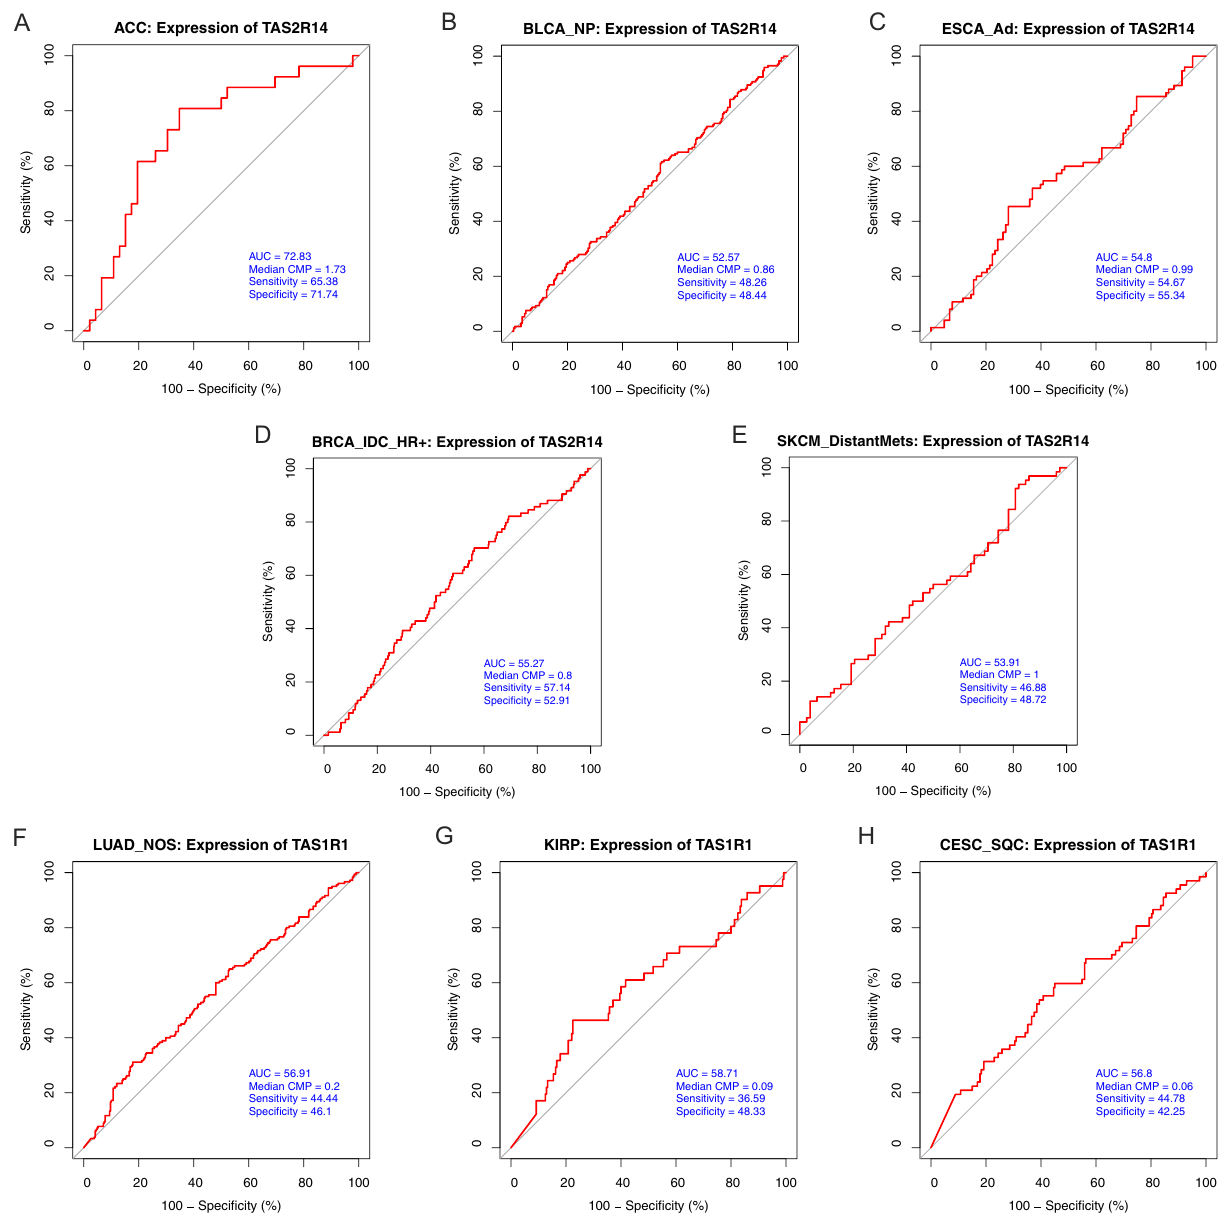
Figure 7. Prognostic roles of TAS2R14 and TAS1R1 for survival in solid tumors. Gene expression data from TCGA was used to generate receiver operating characteristic (ROC) curves using the median counts per million (CPM) cutoffs used in the Kaplan-Meier survival curves from Fig. 6. ROC curves are shown for TAS2R14 in ( A ) adrenocortical cancer (ACC), ( B ) non-papillary bladder cancer (BLCA_NP), ( C ) esophageal adenocarcinoma (ESCA_AD), ( D ) hormone receptor positive infiltrating ductal breast carcinoma (BRCA_IDC_HR +), and ( E ) distantly metastatic skin melanoma (SKCM_DistantMets). ROC curves were also generated for TAS1R1 in ( F ) lung adenocarcinoma (LUAD_NOS), ( G ) kidney papillary cell carcinoma (KIRP), and ( H ) cervical esophageal squamous cell carcinoma (CESC_SQC). The red line represents the sensitivity curve, and the blue line represents random chance. The X axis shows the false positive rate, presented as ‘100–Specificity (%)’. The Y axis indicates the true positive rate, shown as ‘Sensitivity (%)’. The area under the receiver operating characteristics was highest for TAS2R14 in adrenocortical cancer (sensitivity 65.4% and specificity 71.7%). ACC adrenocortical cancer; BLCA_NP non-papillary bladder cancer; BRCA_IDC_HR + hormone receptor positive infiltrating ductal carcinoma; CESC_SQC cervical esophageal squamous cell carcinoma; CPM counts per million; ESCA_AD esophageal adenocarcinoma; KIRC kidney clear cell carcinoma; KIRP kidney papillary cell carcinoma; LUAD_NOS lung adenocarcinoma; ROC receiver operating characteristic; SKCM_DistantMets distantly metastatic skin